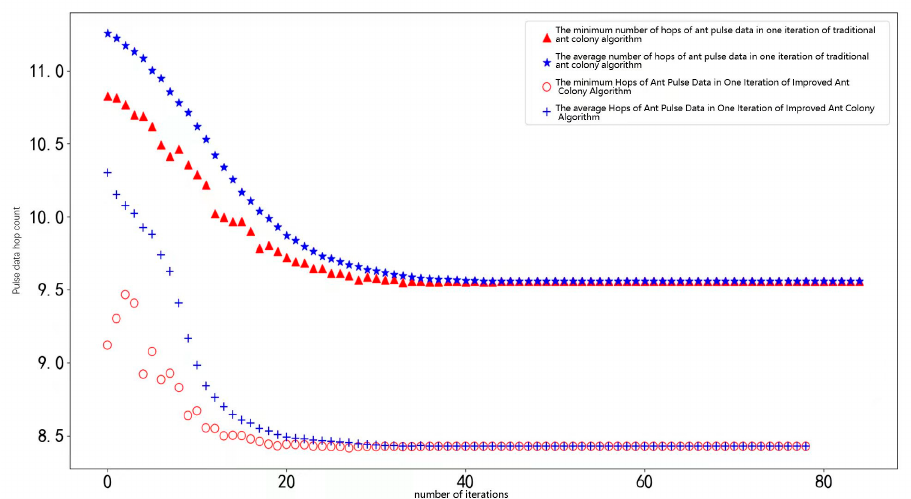
Figure 3. Comparison between the traditional and the improved ant colony algorithm.